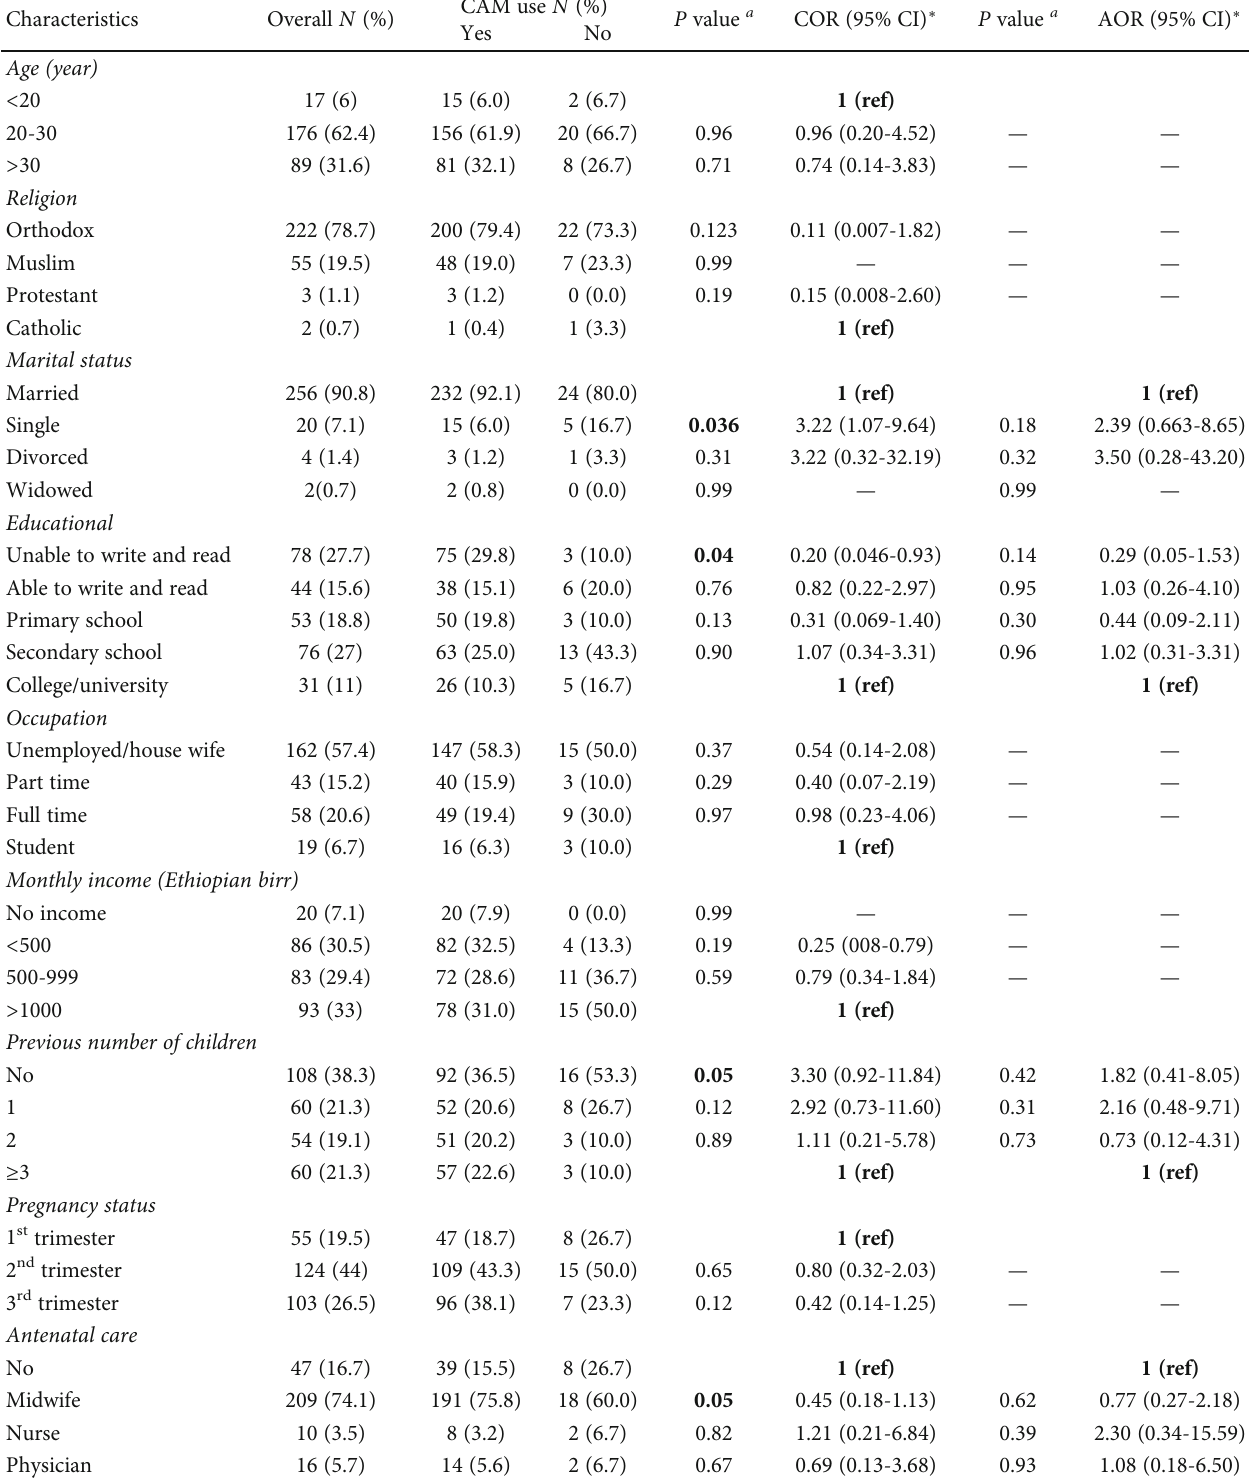
Table 1: Sociodemographic characteristics of pregnant women and their association with CAM use in univariate and multiple logistic regression models ( N = 282